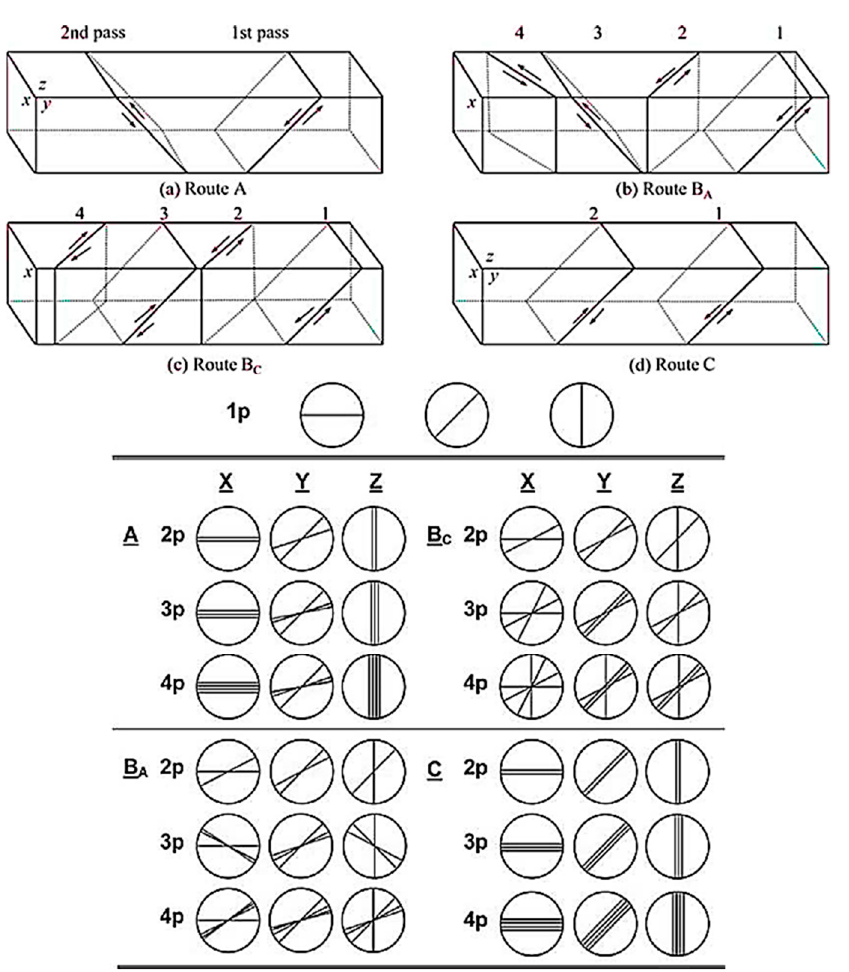
Figure 26. Slip system for different routes [14,20]:( a ) Route A; ( b ) Route B A ; ( c ) Route B C ; ( d ) Route C. Reproduced with permission from Springer Nature. Reproduced with permission from Elsevier Ltd.